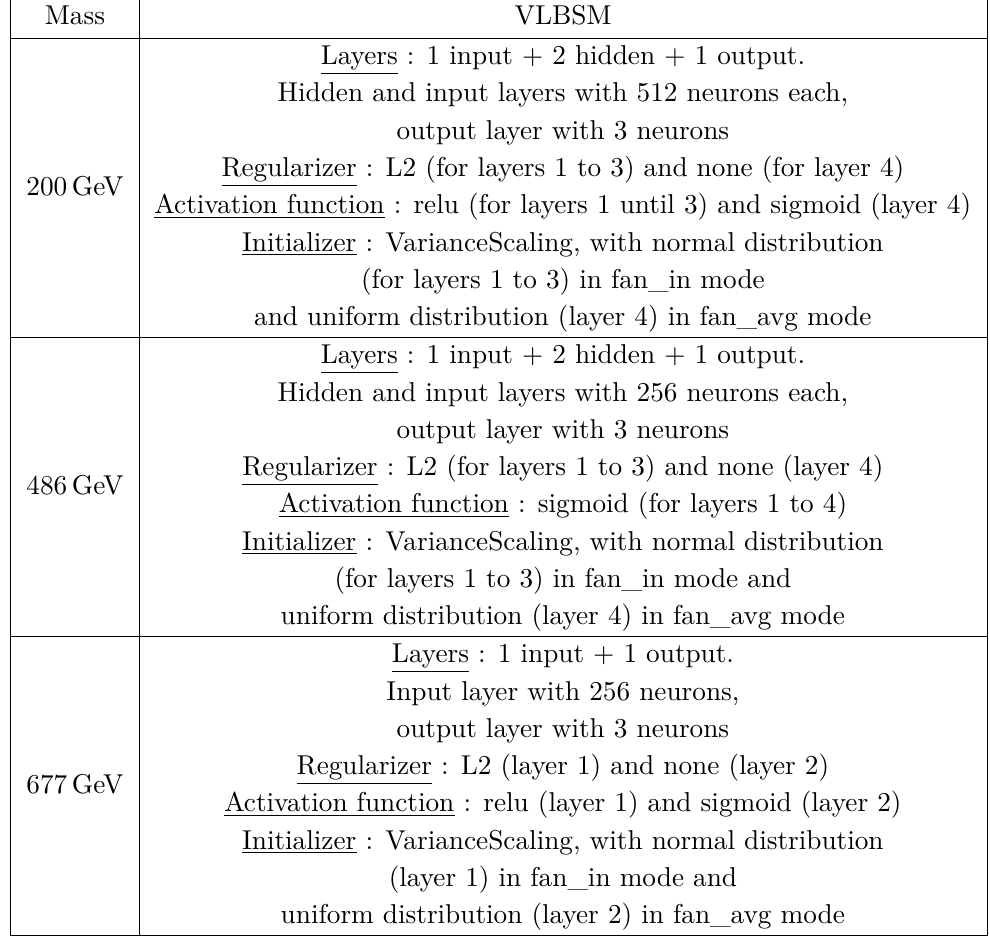
Table 15. Neural networks architectures employed for each mass of the lightest VLL for VLBSM. The architecture is determined following the implementation of an evolutive algorithm that max- imises the Asimov